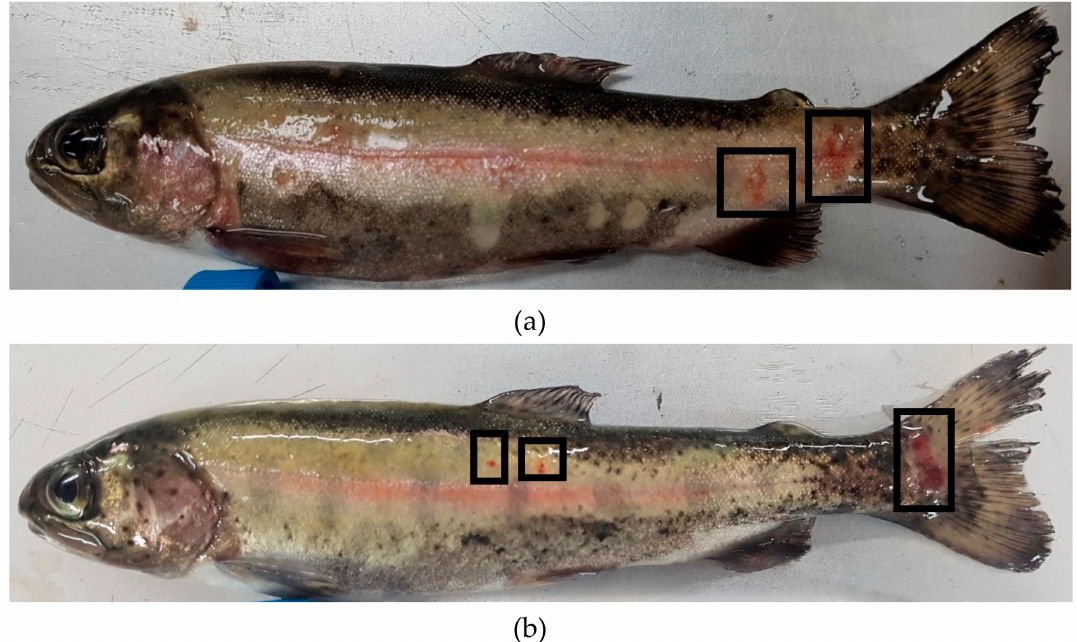
Figure 1. Fish showing clinical signs of red spotted lesions resembling RMS on the lateral side of the body ( a ) and caudal fin ( b